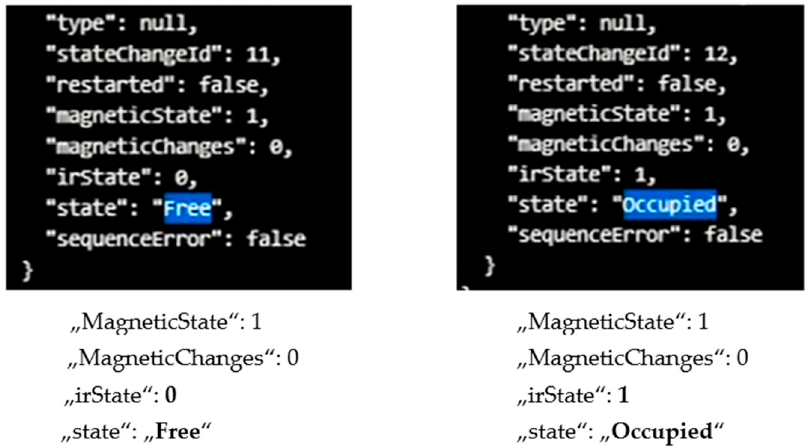
Figure 24. The proposed solution scenario for smart parking. The changes in the occupation status of the parking spot are tracked and recorded in real time. the parking spot are tracked and recorded in real